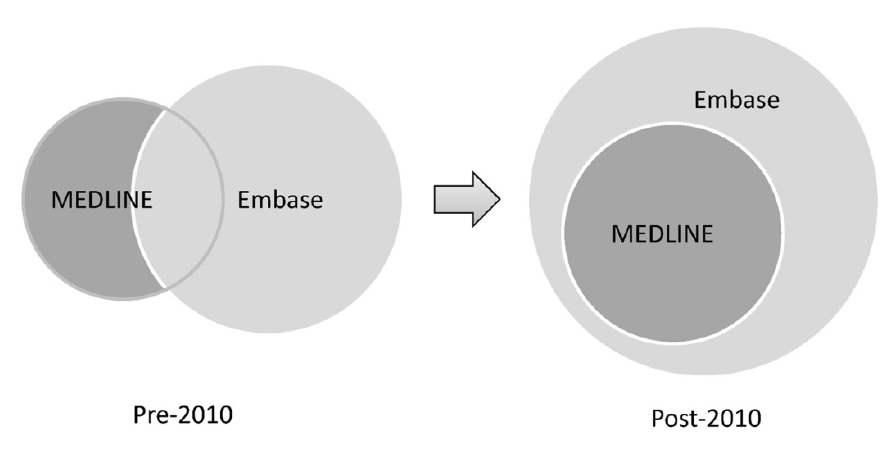
Figure 1 Coverage overlap of MEDLINE and Embase pre- and post-2010